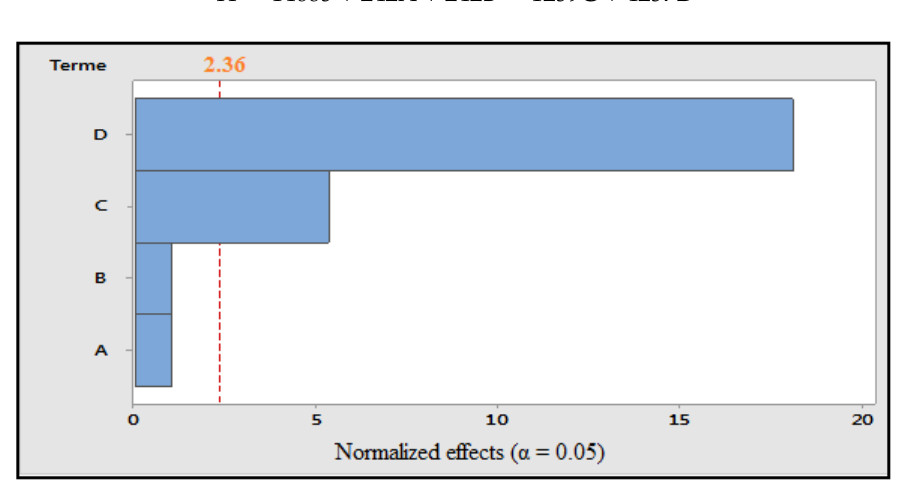
Figure 1. Pareto diagram of normalized effects (α = 0.05). A: concentration of solvent; B: grinding; C: maceration time; and D: ultrasonication